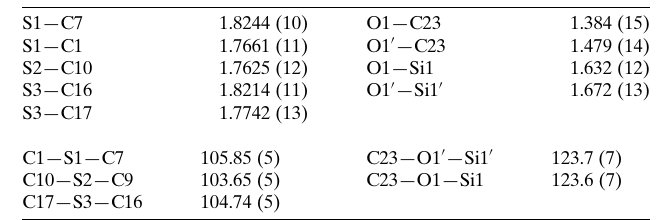
Table 1 Selected geometric parameters (A˚ , (cid:2) ) for 1 .